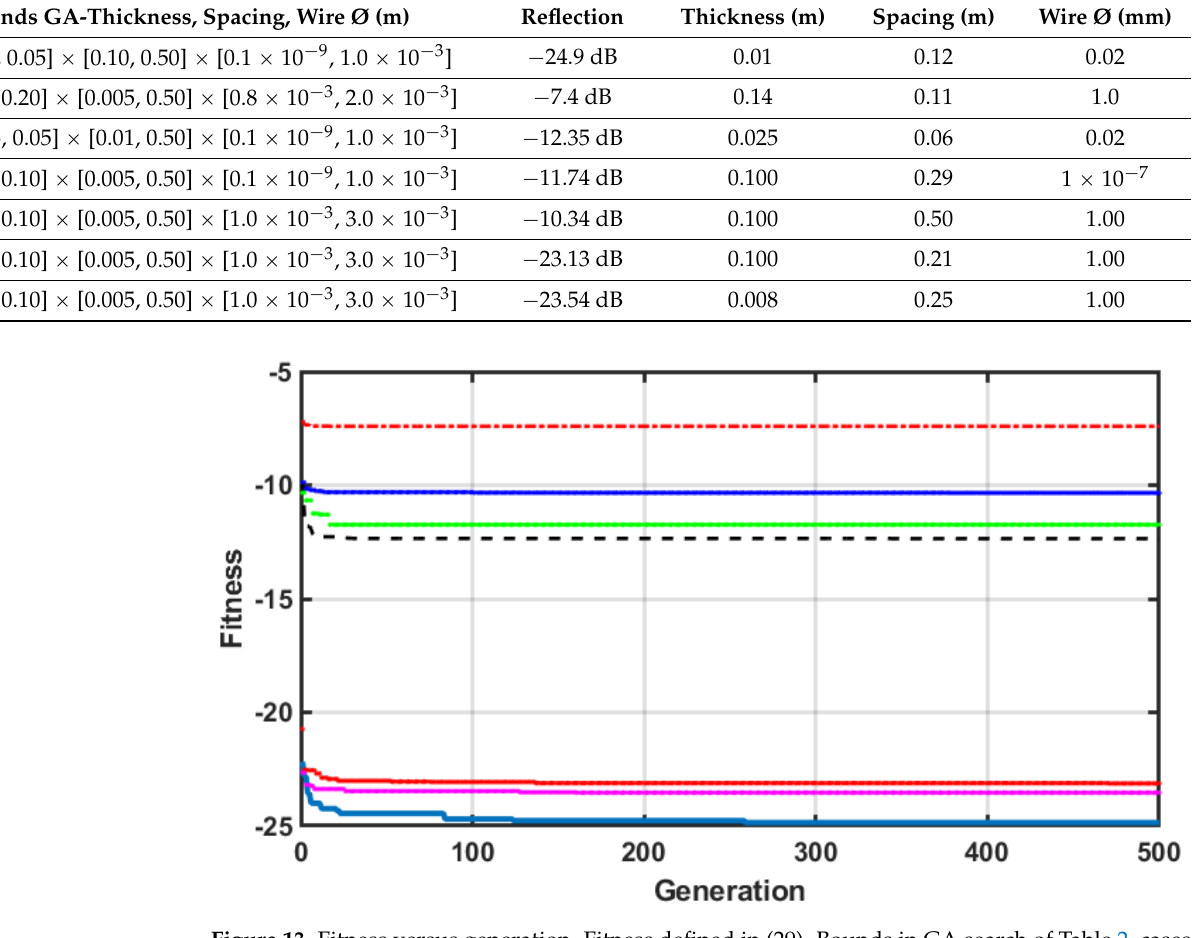
Figure 13. Fitness versus generation. Fitness defined in (29). Bounds in GA search of Table 2, cases (1)-(2)-(3)-(4)-(5)-(6)-(7) of Table